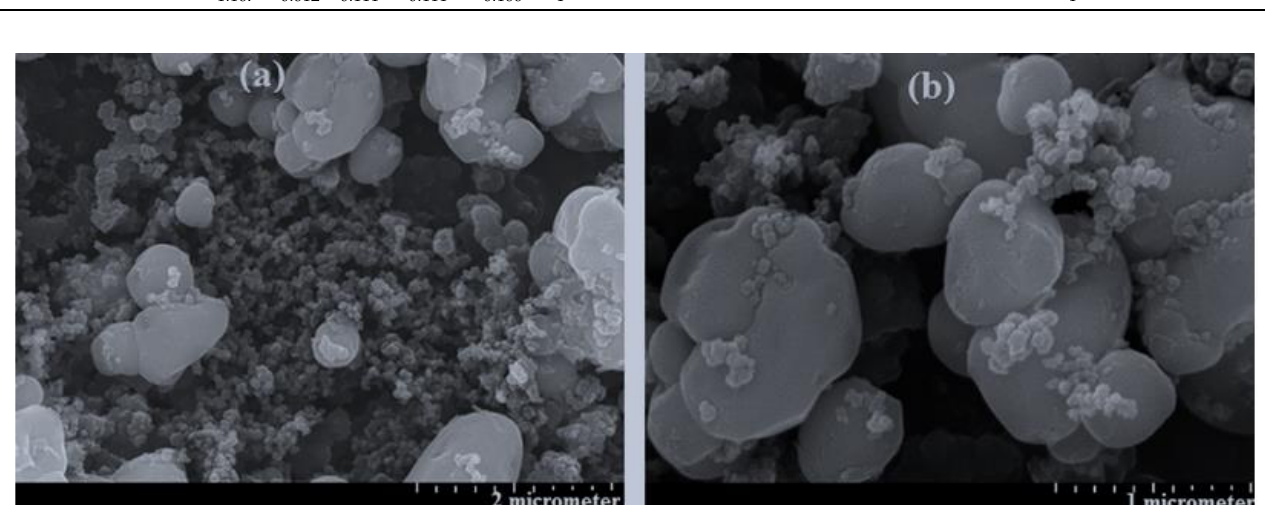
Figure 1. The SEM of two cathode materials for two samples including ( a ) = sample 21 =